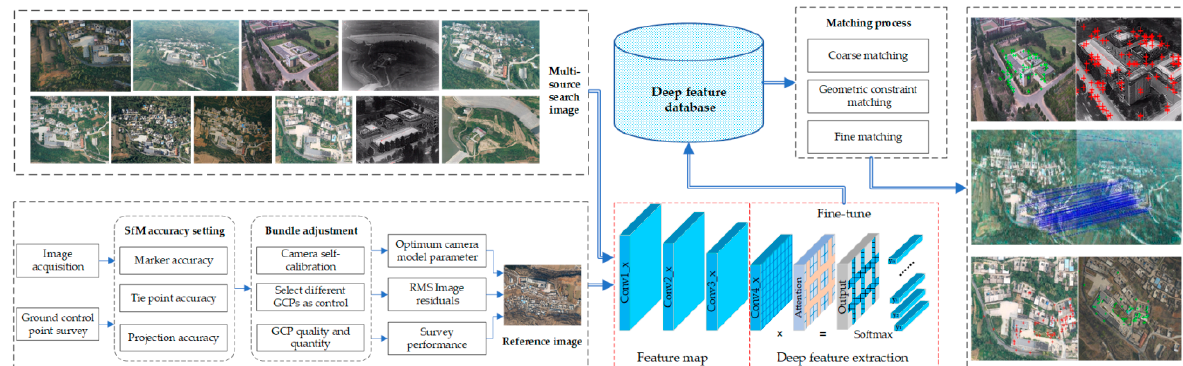
Figure 1. The overall workflow of the multi-source image matching method.